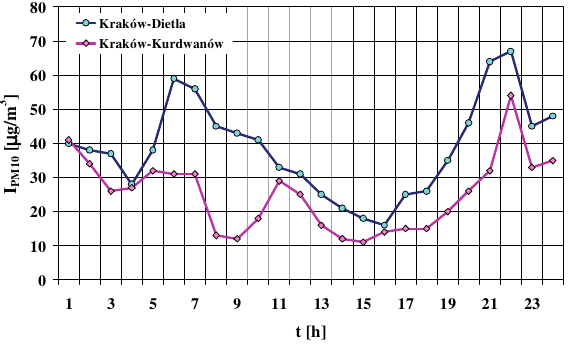
Fig. 3. The immission of particulate matter PM10 on 8 June 2016 The mean value of the immission of particulate matter PM10 in this particular case is considerably higher at the Kraków–Dietla station. This indicates that the automotive industry has a major impact on air pollution. However, these values of the immission are four times lower than in winter season. is particularly visible in Figs 4 and 5.